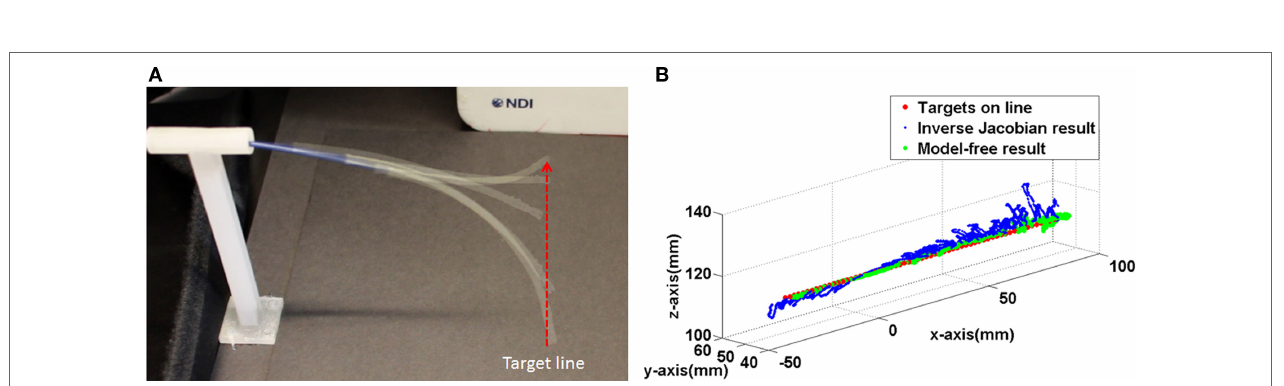
FigUre 12 | (a) initial shape of the catheter in the free space experiment (B) shape of the catheter after contact on the target location using the free model position control and showing the shaft deflection during the experiment (c) the absolute distance error during the